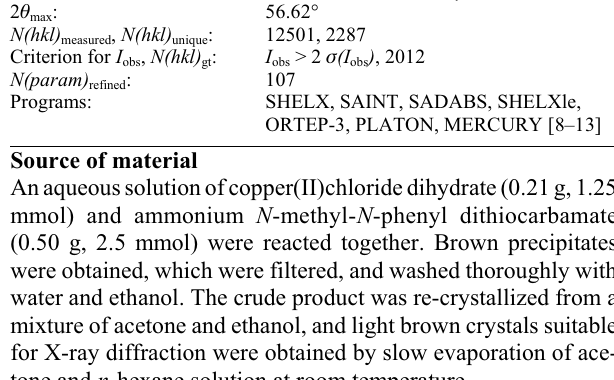
Table 2. Atomic coordinates and displacement parameters (in Å 2 )